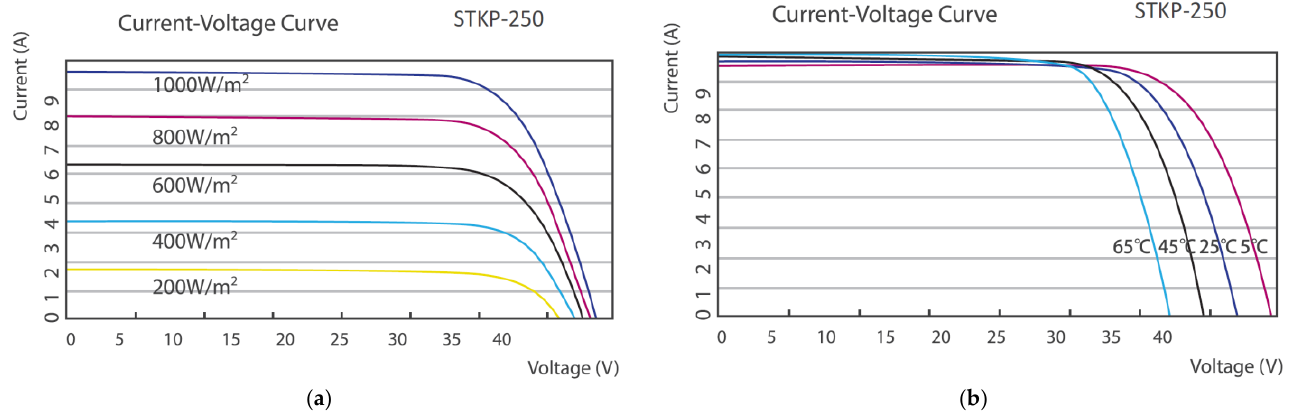
Figure 3. I-V curves of an SPV panel for ( a ) different solar radiation conditions and ( b ) different temperature conditions (adapted with permission from Ref. [107] Copyright 2022, Solar Electric London UK).